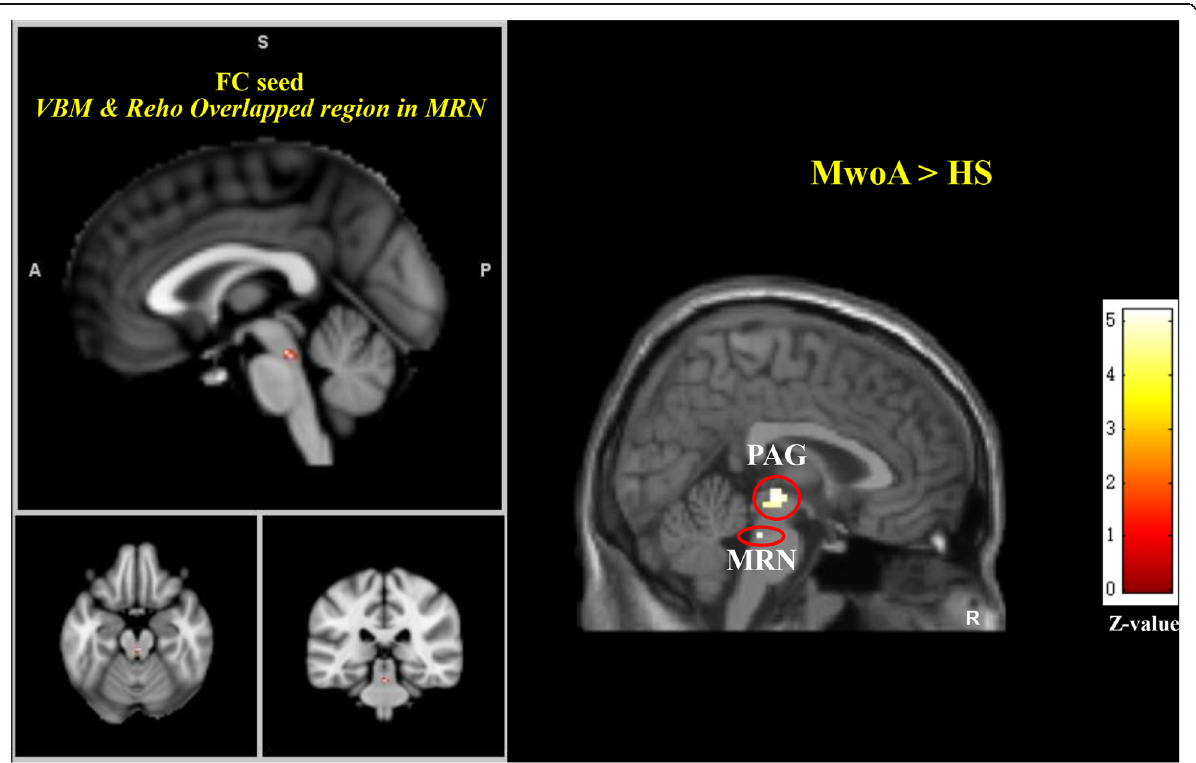
Fig. 3 Altered median raphe nuclei functional connectivity in MwoA patients. MwoA patients showed higher median raphe nuclei functional connectivity with local median raphe nuclei and PAG compared to HS. A threshold of P < 0.05 family wise error (FWE) correction at cluster level were applied for all comparisons. A, anterior; FC, functional connectivity; HS, healthy subjects; MwoA, migraine without aura; P, posterior; PAG, periaqueductal gray; R, right side; Reho, regional homogeneity; MRN, median raphe nuclei; S, superior; VBM, voxel-based